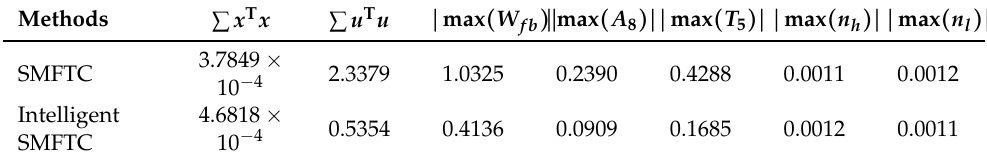
Table 2. Control performance comparison of aircraft engine.